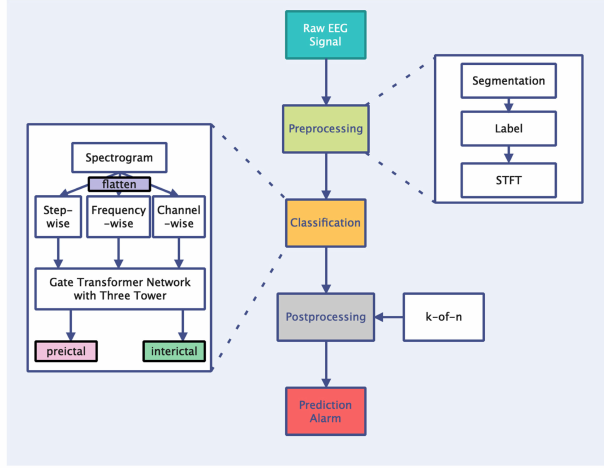
Figure 5. Workflow of the seizure prediction